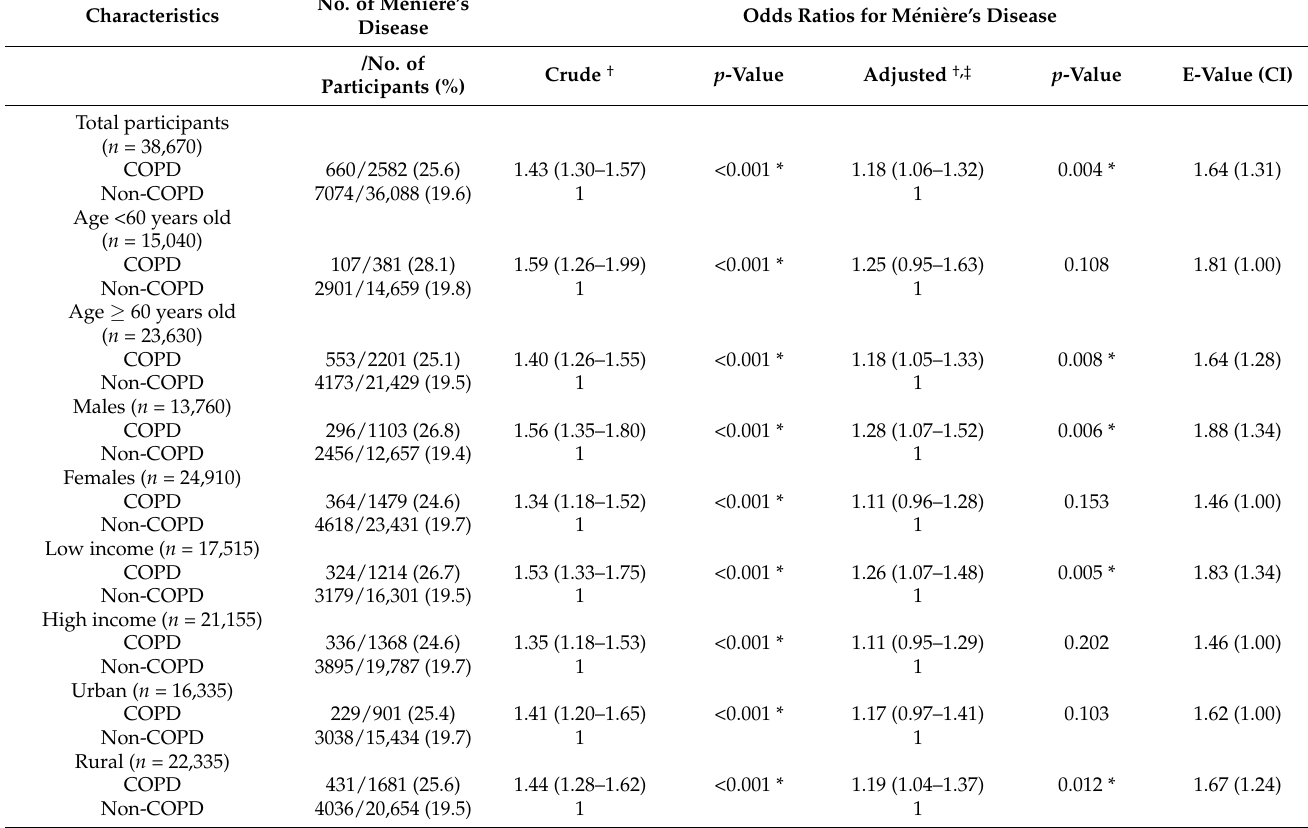
Table 2. Odds ratios (95% confidence intervals) of chronic obstructive pulmonary disease for M é ni è re’s disease with subgroup analyses according to age, sex, income, and region of residence.